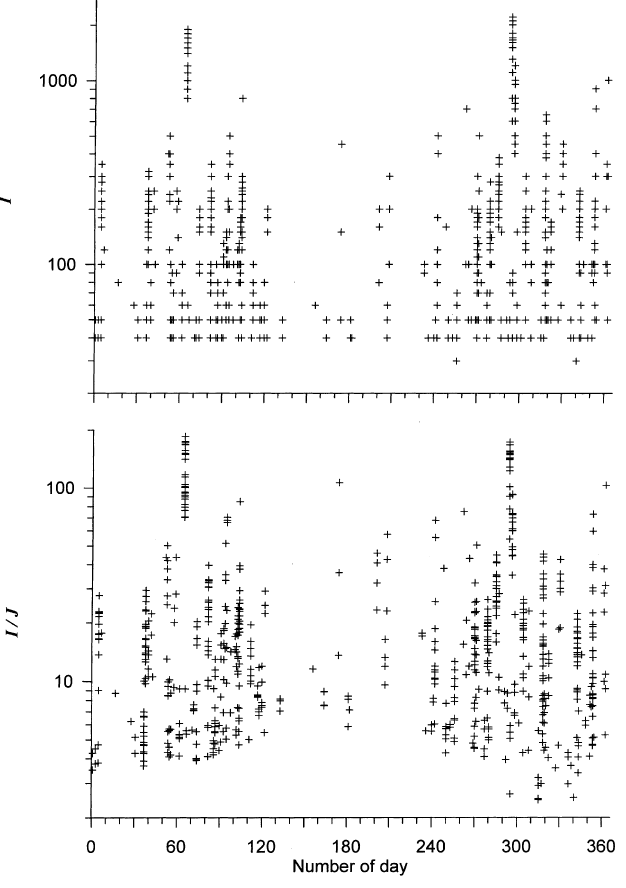
Fig. 4. Dependence of SAR arc intensity I ( top ) and the ratio I = J ( bottom ) on the number of day in the year. The value of J is given by Eq. (7)